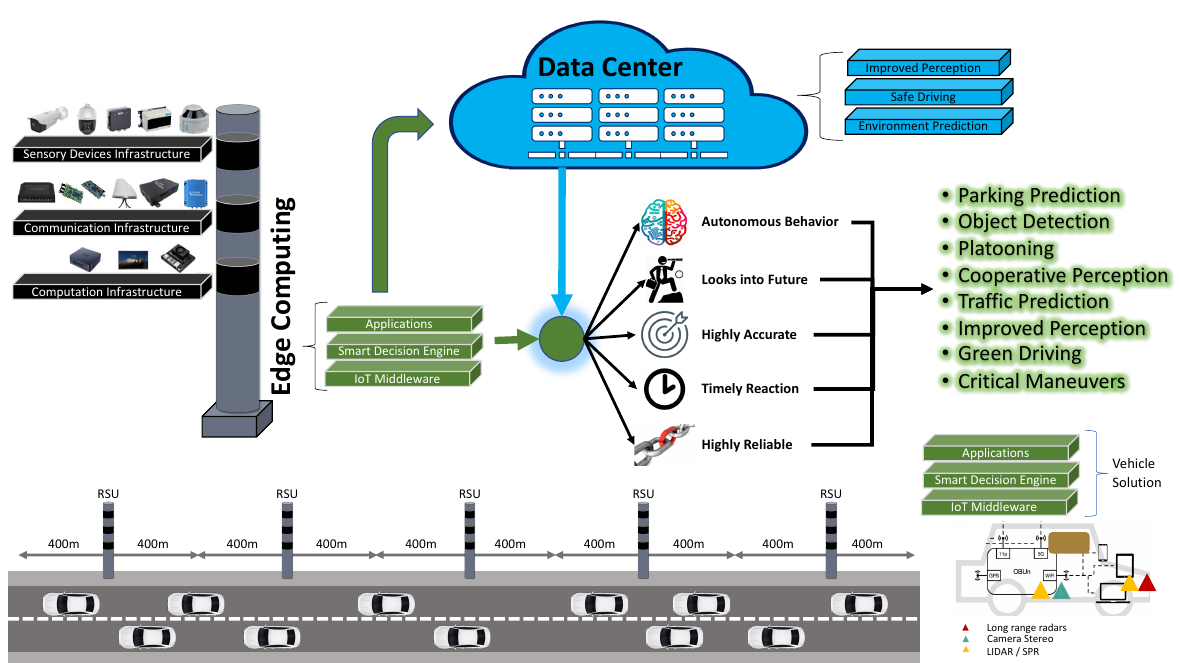
Figure 2. Details of the CCAM and evolved roadside